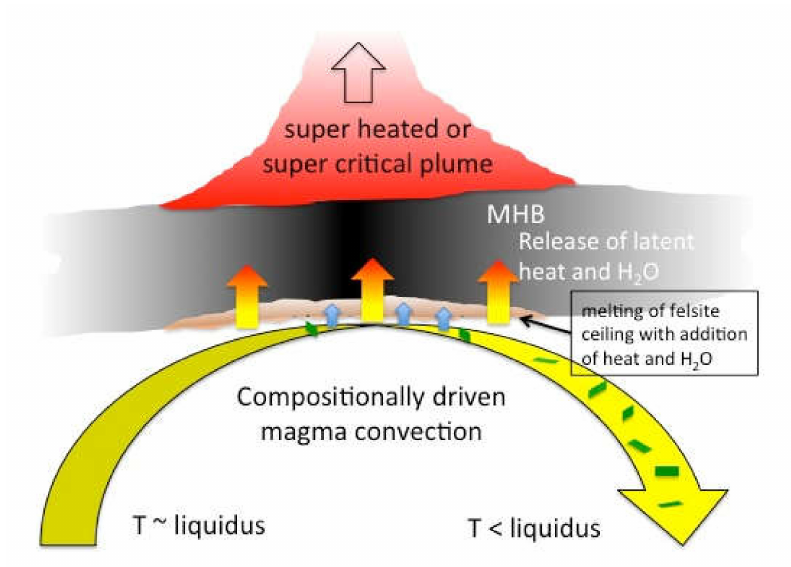
Figure 8. Thermally (density increase due to cooling) and compositionally (density increase due to crystal growth) driven circulation in magma could transfer heat and H 2 O at the lower face of the MHB without coating it with crystals and, in the case of Krafla, partially melting it. This would explain the sparse crystal content of all shallow silicic magmas thus far encountered (Table